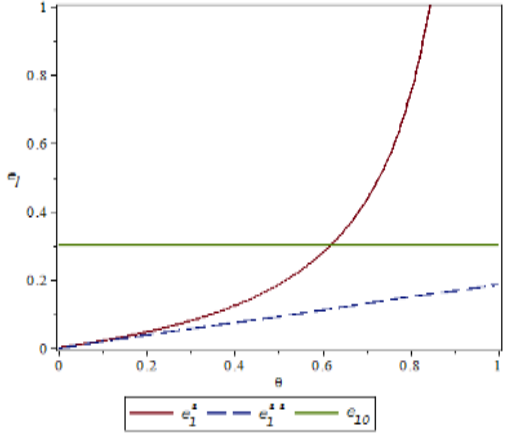
Figure 2. Effect of manufacturer’s behavior θ on the supplier green index.